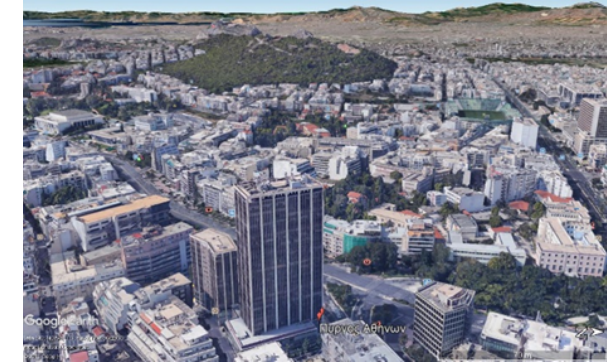
Figure 8: General outlook of the ‘’Tower of Athens” towards Lycabet- tus hill